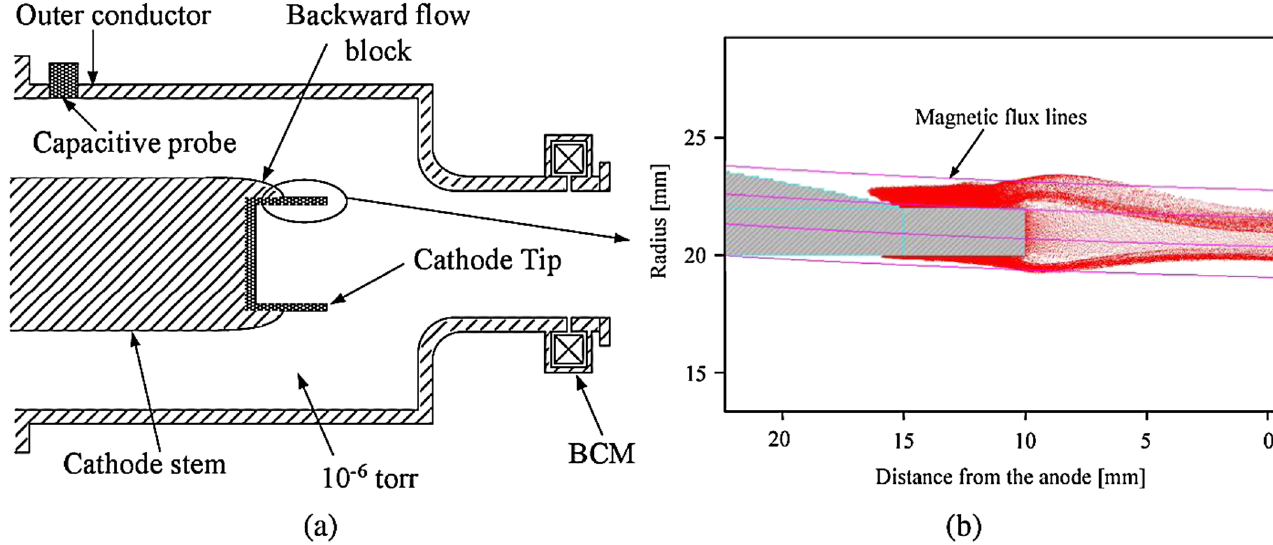
FIG. 1. (Color) (a) Cross section of the gun structure. (b) The beam trajectory at the cathode with full emission. All backward currents are blocked by the cathode holder. Magnetic field of 0.8 T was applied using ten pancake coils.